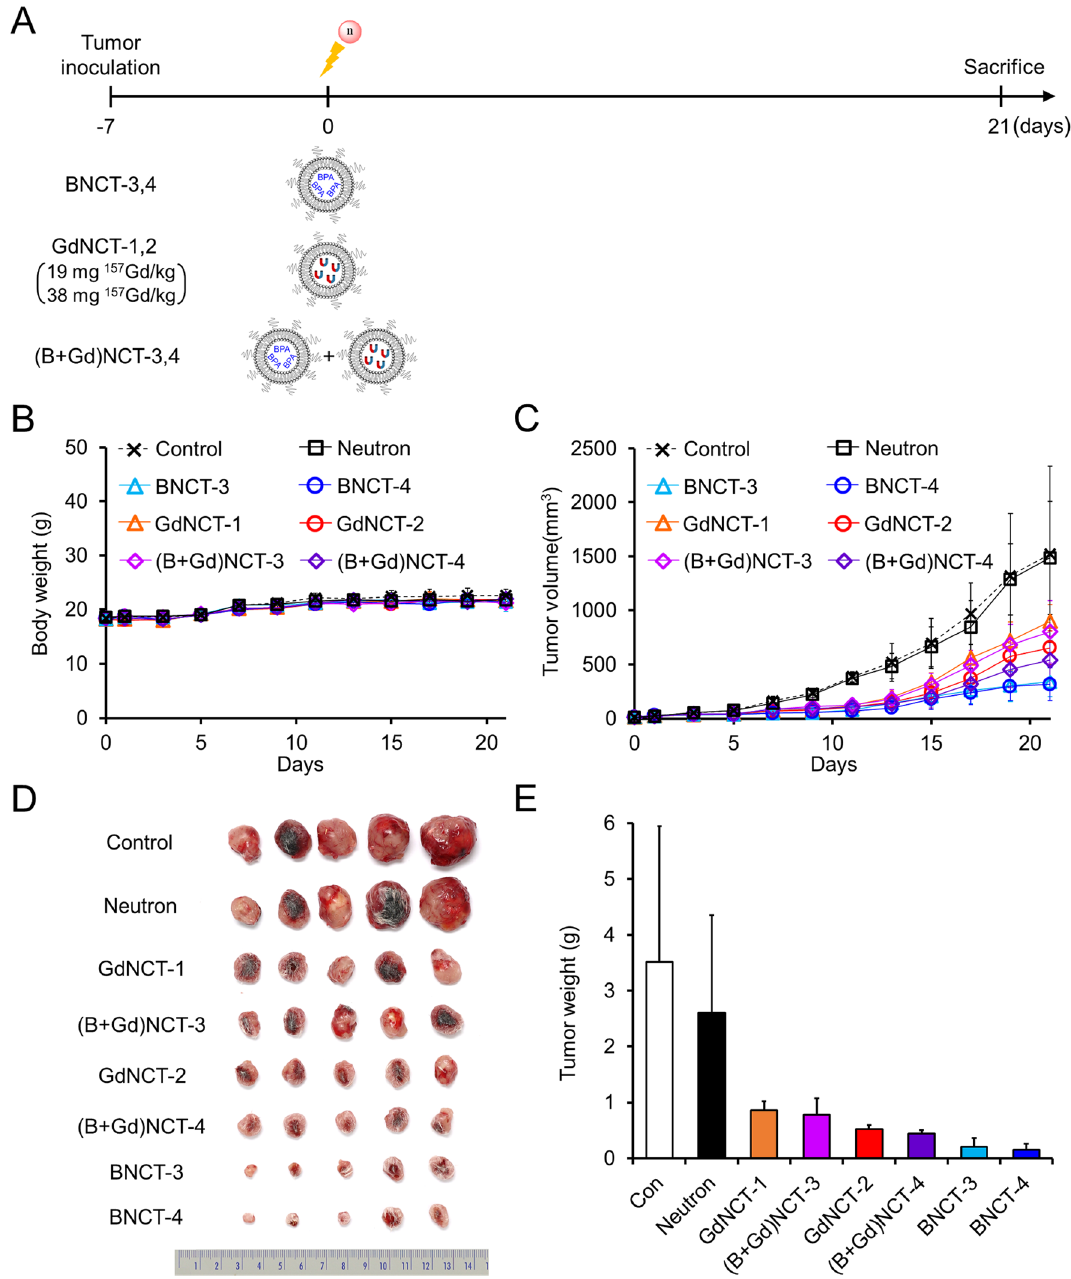
Figure 4. Results of concurrent BNCT and GdNCT combination using BPA-liposomes and Gd-liposomes in CT26 tumor-bearing mice (n = 5). ( A ) General experimental procedure for injection and irradiation. ( B ) Body weights of each group after neutron irradiation. ( C ) Tumor growth curves of each group after neutron irradiation. ( D ) Photographs of tumors resected 21 days after neutron irradiation. ( E ) Average weights of tumors resected on day